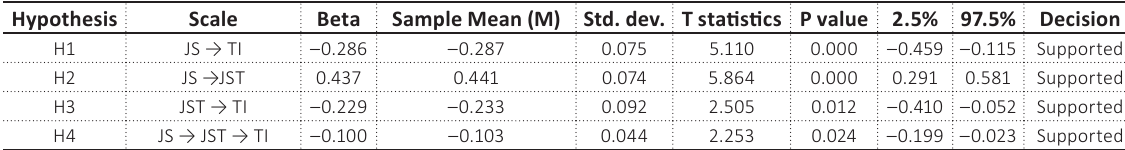
Table 7. Hypotheses testing